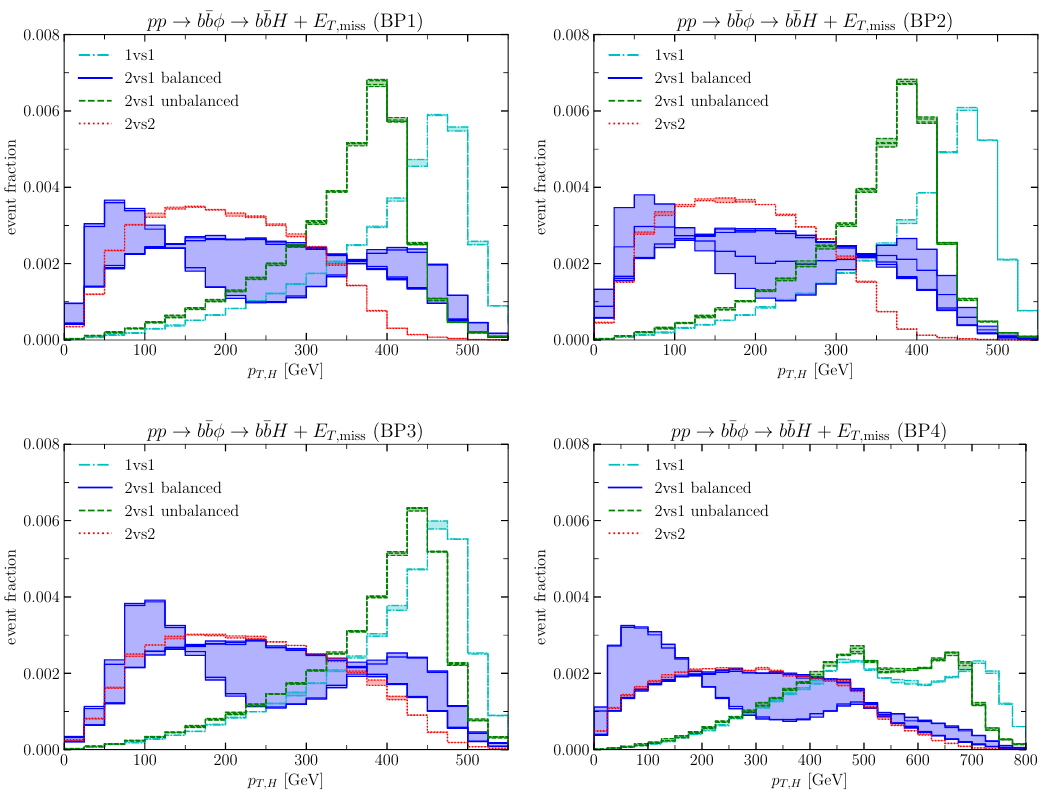
Figure 15. Mono- H + E miss final state: transverse momentum distribution of the di-gamma system T evaluated for BP1 (upper left panel), BP2 (upper right panel), BP3 (lower left panel), and BP4 (lower right panel). All different curves of the 1vs1 topology are contained in the turquoise band; the curves of the 2vs1 balanced topology in the dark blue band; the curves of the 2vs1 unbalanced topology in the green band; and the curves of the 2vs2 topology in the red